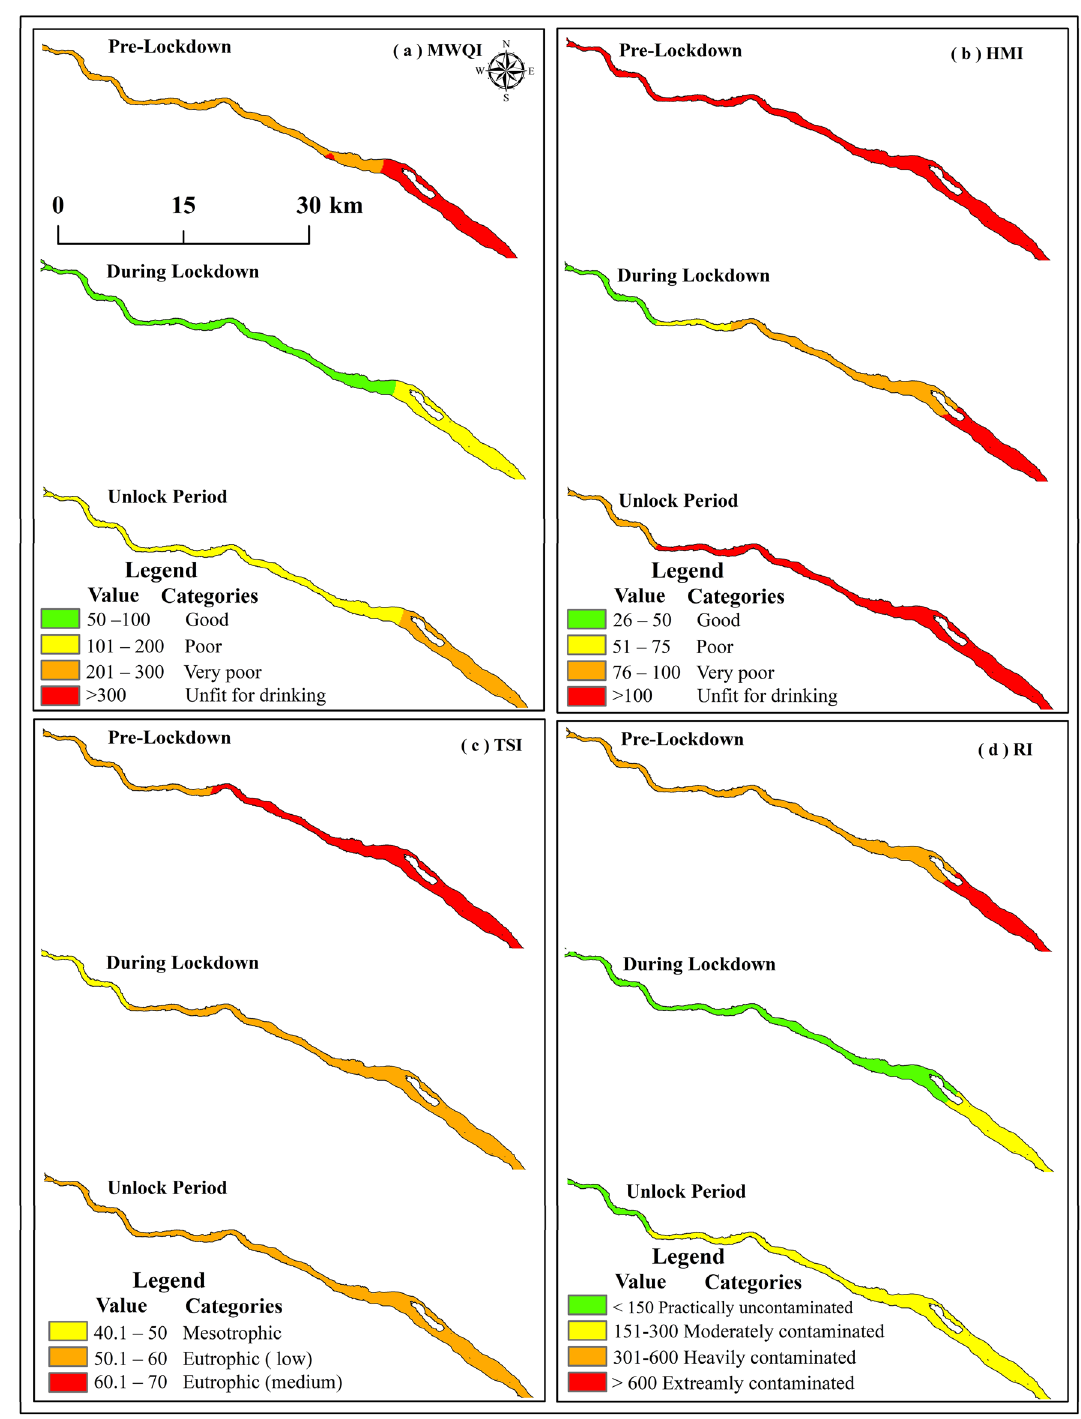
Figure 4. Spatial variation of water quality in three periods based on different water quality index. The diagram is prepared by open. source QGIS 3.16 software (https:// qgis. org/ en/ site/ forus ers/ downl oad. down phase and it rose to -58.24 during unlock phase compared with pre-lockdown phase (December 2019) (Table 3). Unlock phase, HMI showed that the values ranged from 89.32 to 175.06 and 27.27% samples were very poor quality while 72.72% samples were unfit for drinking purpose. Figure 3c is representing individual sampling sites with the heavy metal concentrations of three phases. Potential ecological risk assessment index (RI). In pre-lockdown phase, potential ecological risk index (RI) values showed that it ranges from 411.03 to 654.30 with a mean and SD of 537.45 ± 87.19, which